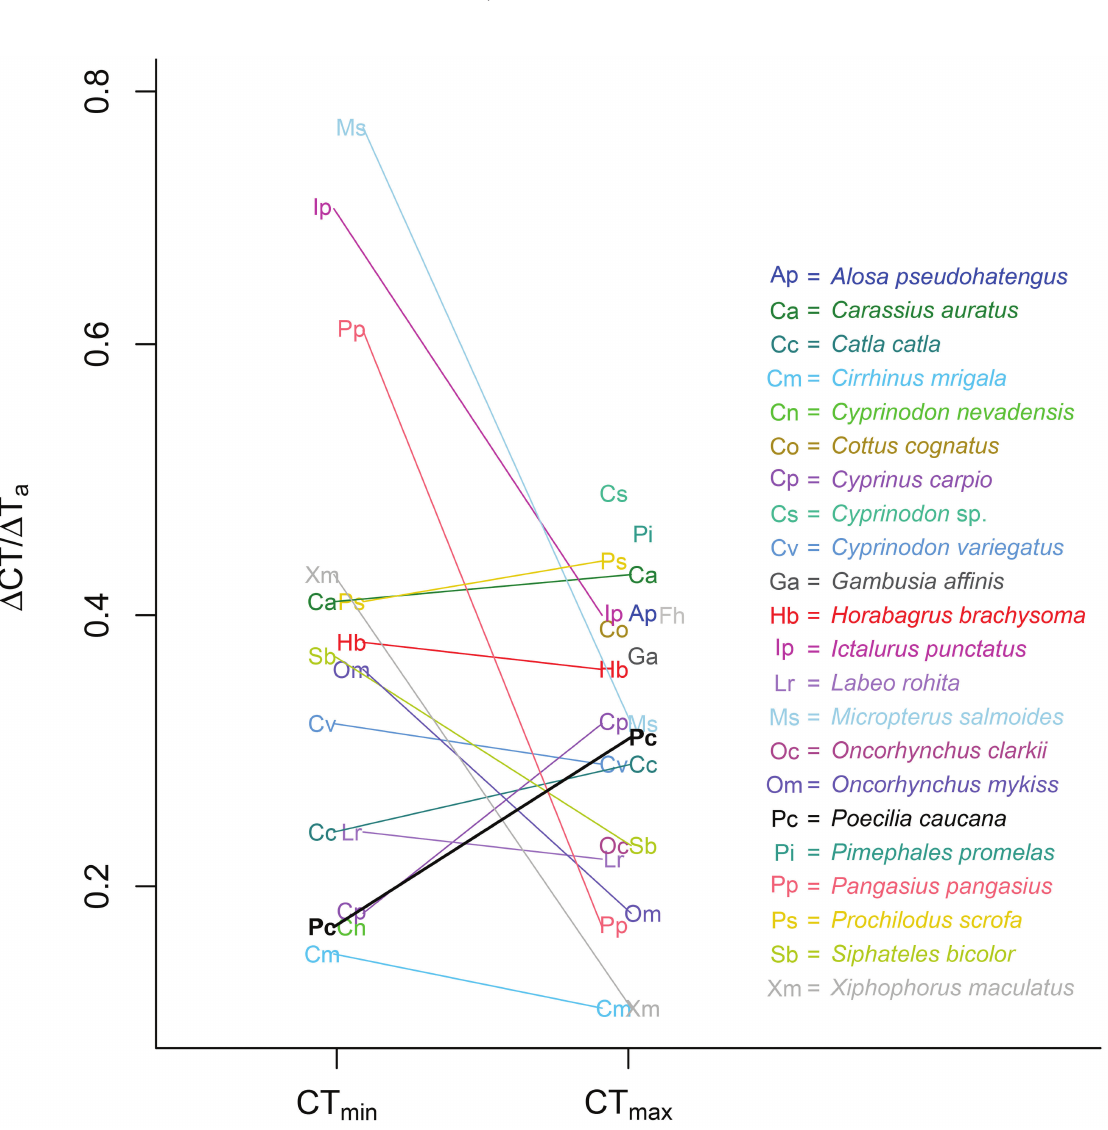
and CT of the min max